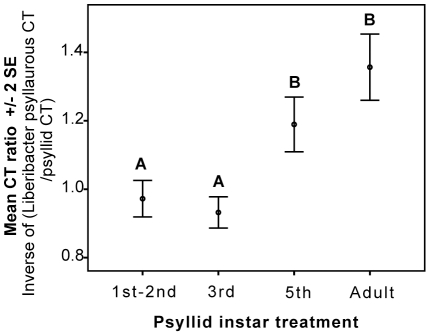
Young tomato psyllids carry the lowest titer of Lps.Relative abundance of the Lps IGS gene for four psyllid life stages compared to the single-copy insect host gene (FORKHEAD). Error bars are the 99% confidence interval of the mean. Letters indicate that treatments are significantly different at a 0.01 level using FORKHEAD as a covariate in ANCOVA. N = 24 psyllids per life stage.